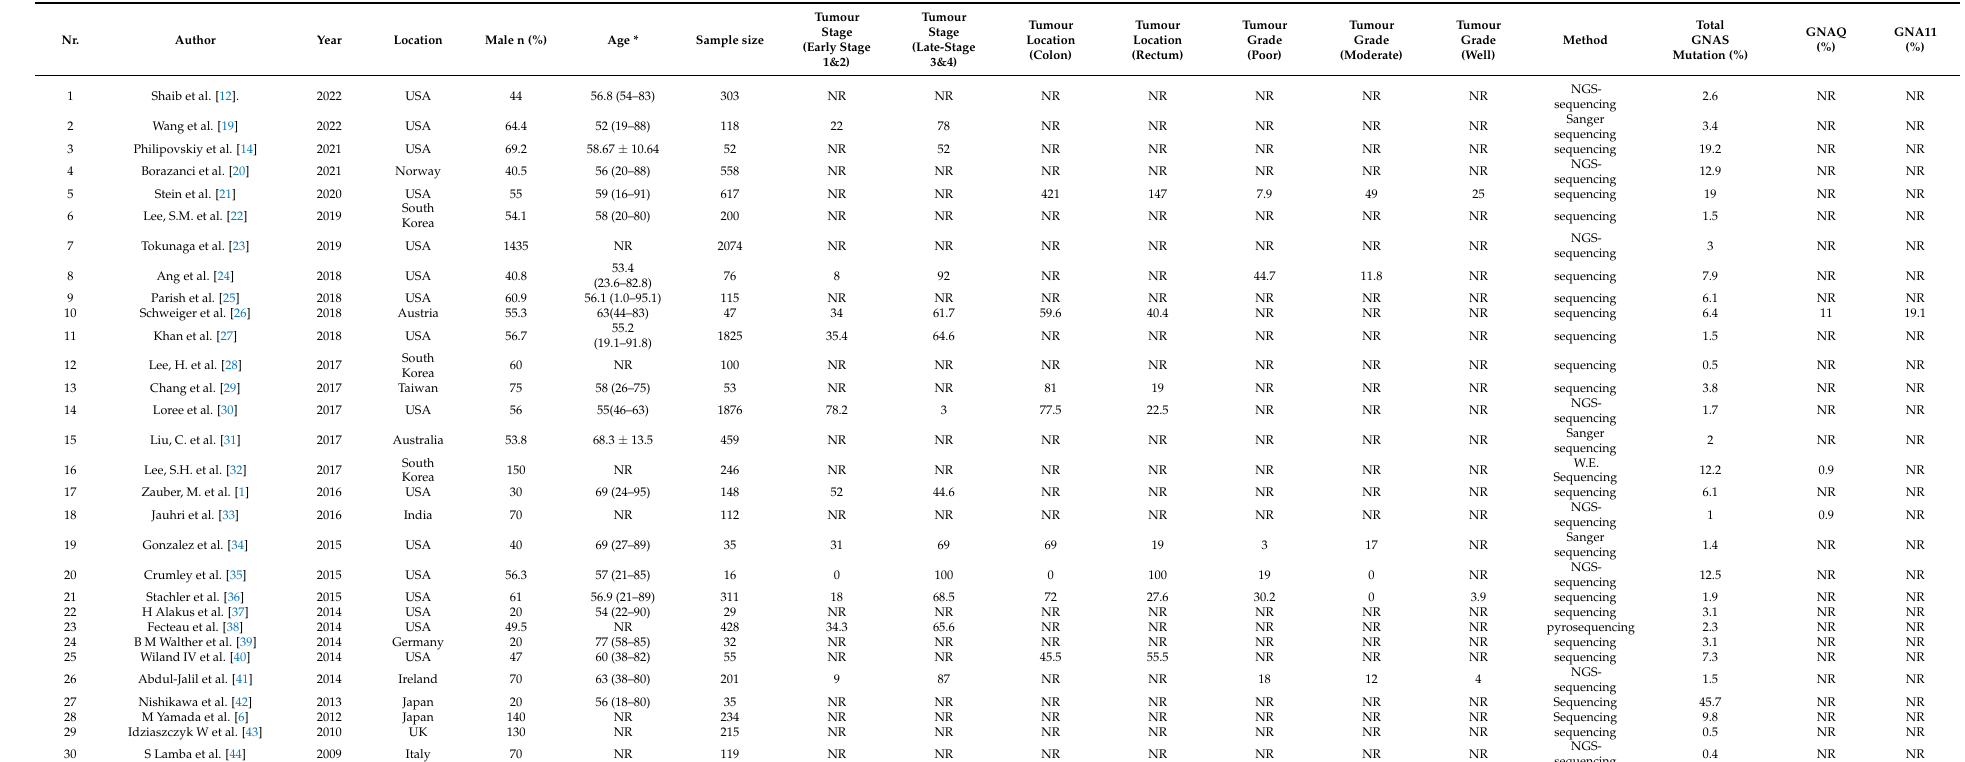
Table 1. Major characteristics of the prevalence of KRAS screening studies included in the